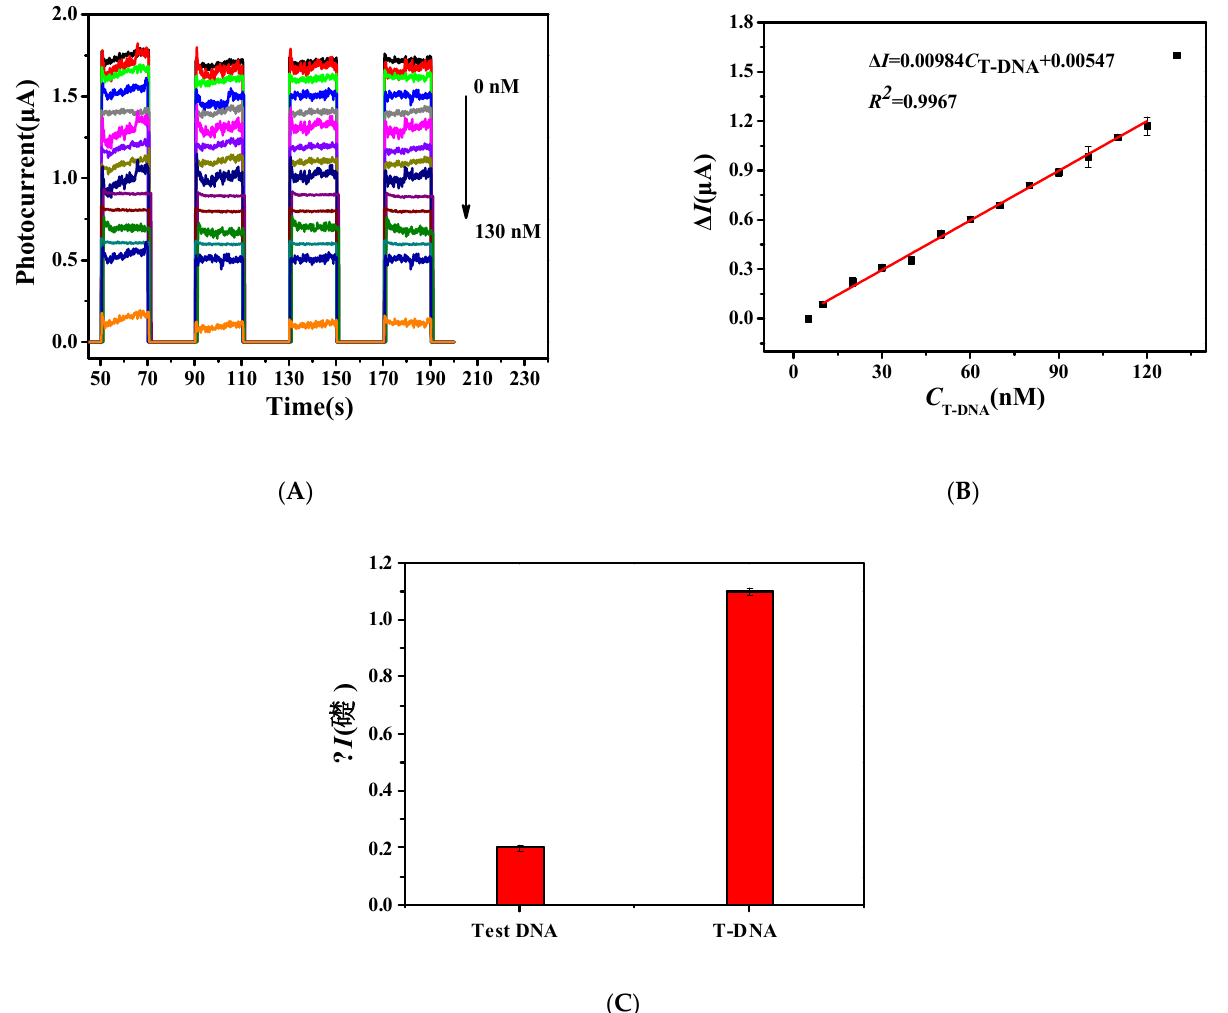
Figure 6. ( A ) Photocurrent and ( B ) linear fitting of the constructed electrode after adding different concentrations of T-DNA. ( C ) Photocurrent comparison after adding different DNA. ( C ) Photocurrent comparison after adding different